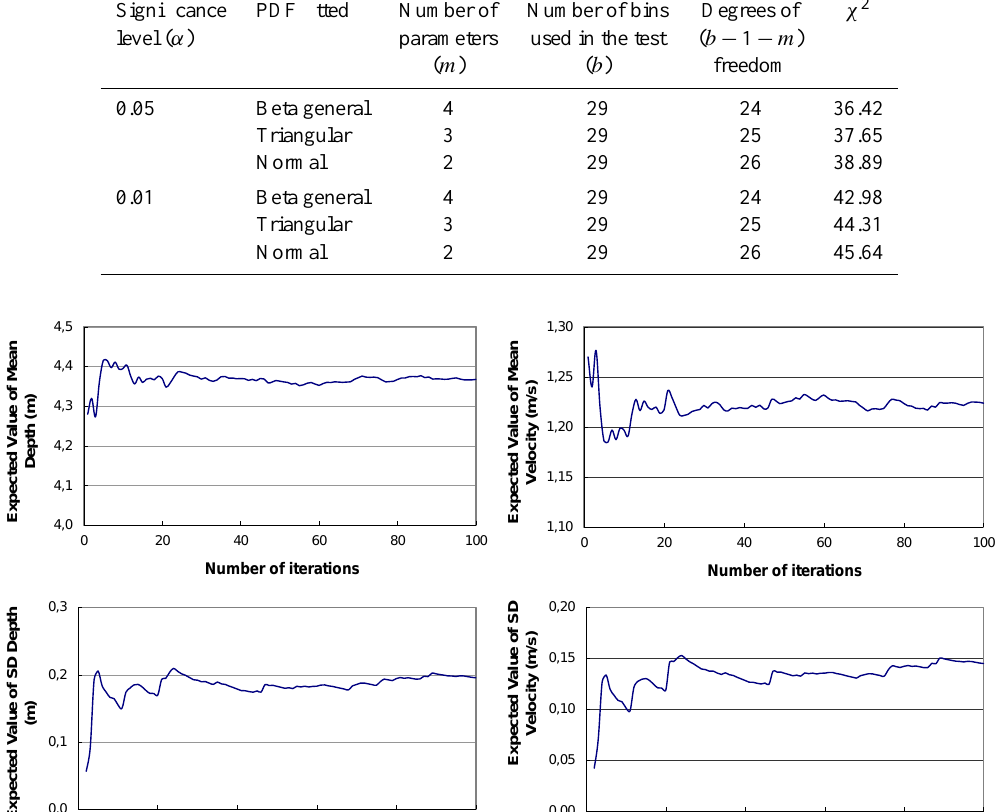
Table 8. Uniform flow model. Values of χ 2 statistic.